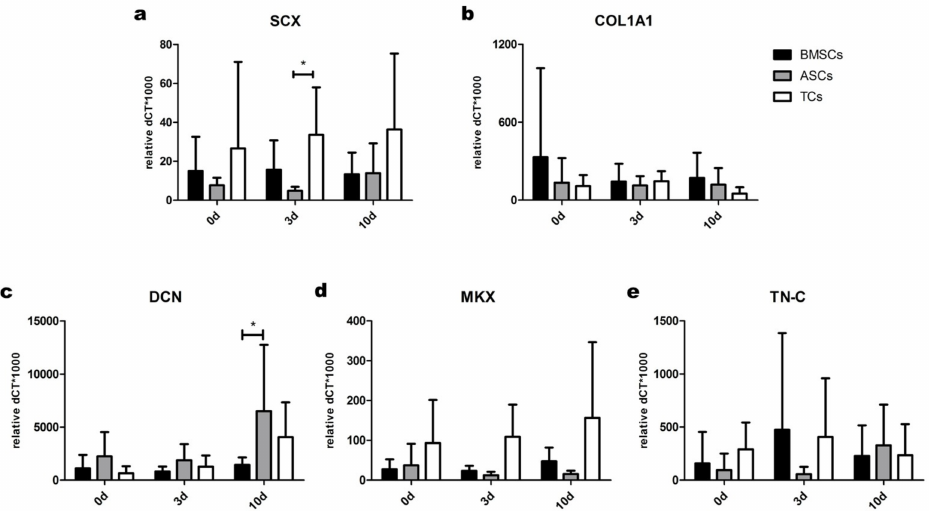
Figure 3. Basal expression of tendon markers in BMSCs, ASCs and TCs. Basal levels of ( a ) SCX; ( b ) COL1A1; ( c ) DCN; ( d ) MKX and ( e ) TN-C were evaluated by gene expression analysis in the three different cell types without tenogenic media supplementation. Data are expressed as mean dCT* 1000 ± SD. n = 7. * p <